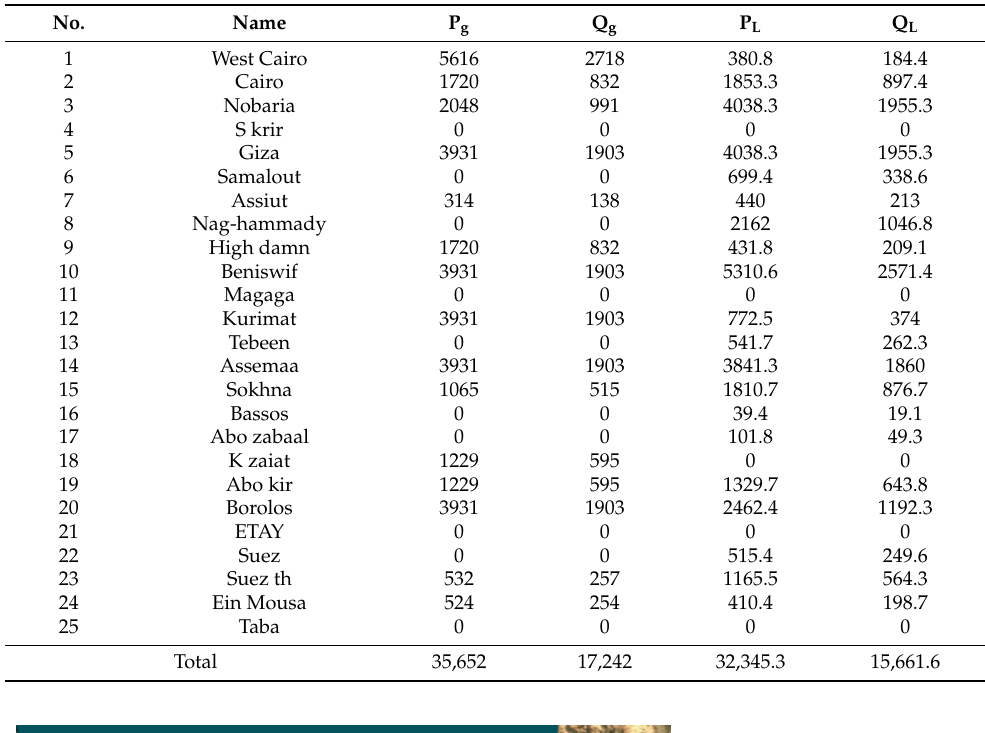
Table 1. The 500 kV Egyptian power system data in 2022.